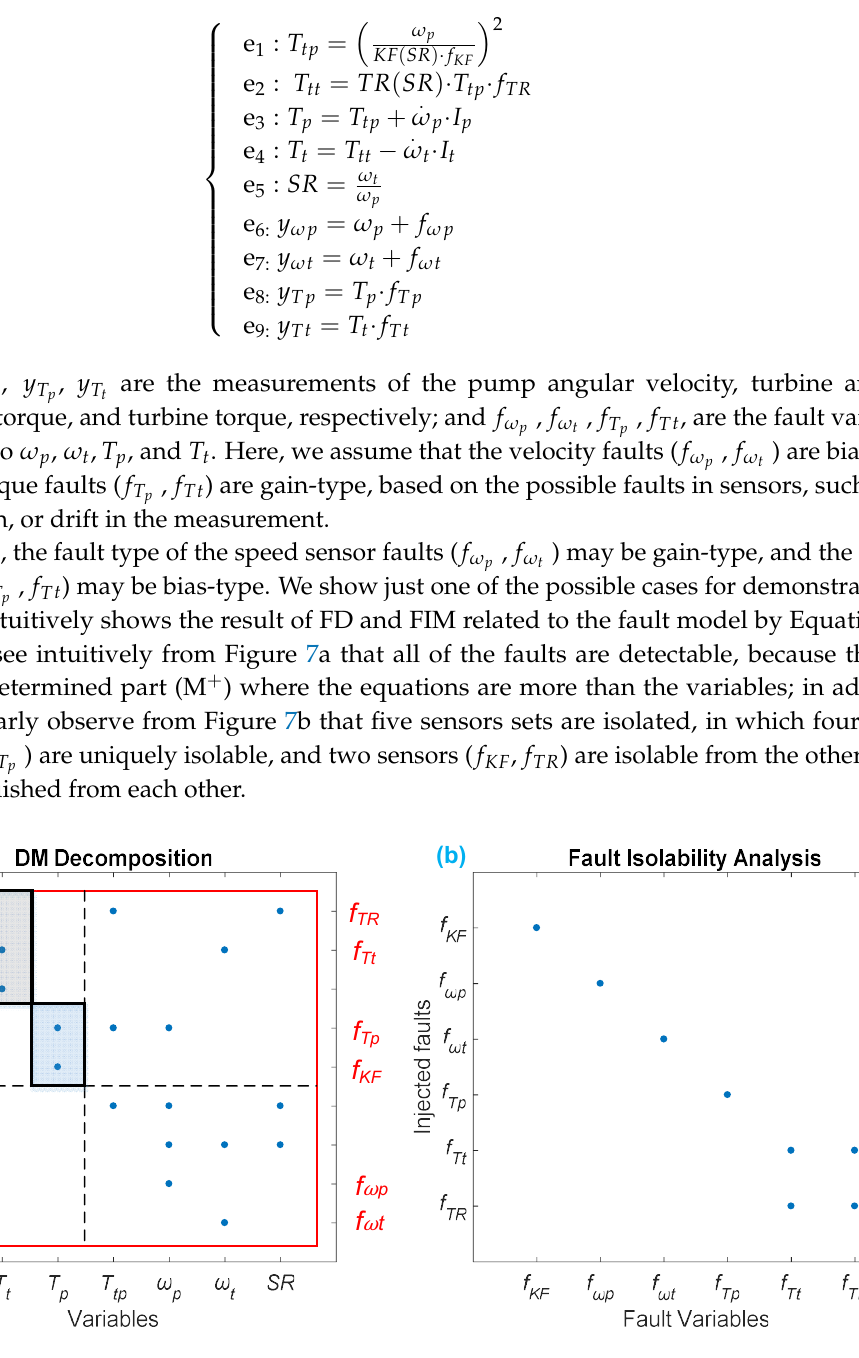
Figure 7. Result of FD and FIM of placing four sensors on ω p , ω t , T p , and T t : ( a ) DM decomposition, where all six faults are detectable, because they all lie in M + ; ( b ) FIM of the HTC, where four faults are uniquely isolable, leaving two faults isolated from the others, but none isolable from each other.